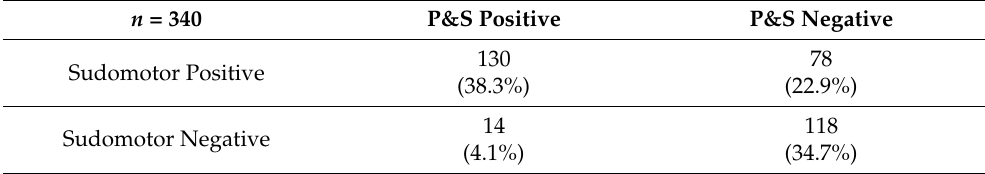
Table 2. Comparison of SFD indications from SweatC™ sudomotor testing (sudomotor) and P&S monitoring (P&S), for the entire cohort, based on the specific definition of PAN. See text for